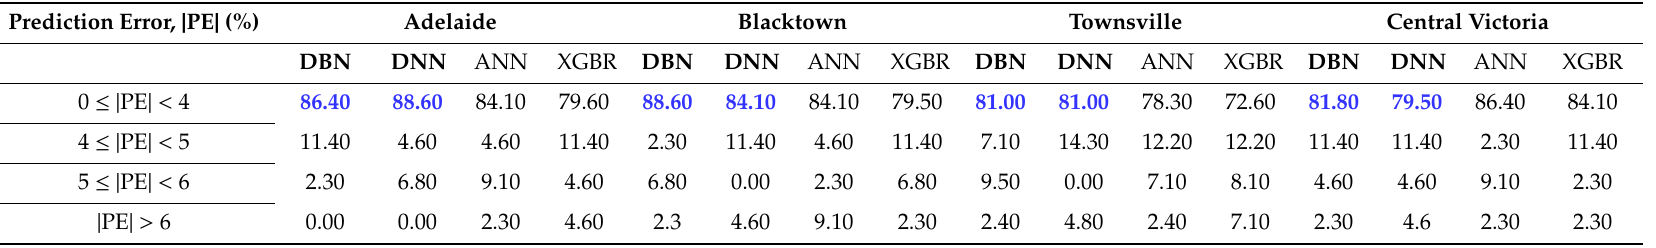
Table 9. The percentage frequency of the absolute prediction errors, | PE | , in di ff erent error bands in the testing phase, encountered by the deep learning model within respect to its comparative counterpart models: a single hidden layer neural network (ANN) and ensemble models for Australia’s solar cites. The best model is highlighted in blue / bold